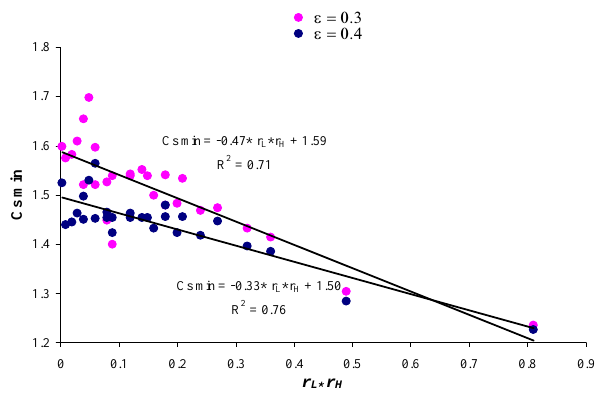
Fig. 7. Minimum skewness coefficient vs. r L · r H for 3 p =21, ε =0.3 (magenta) and 3 p =21, ε =0.4 (blue).